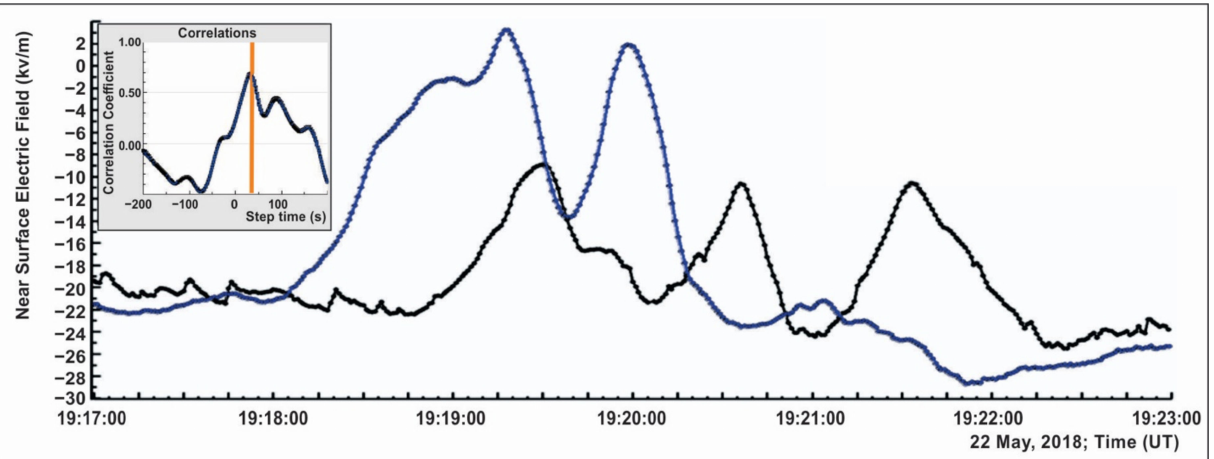
Figure 17. 1s time series of NSEF disturbances measured by electric field sensors located on the roof of MAKET building (black) and located above housing of GAMMA scintillators on 1 m high mast (blue). In inset —the delayed correlations